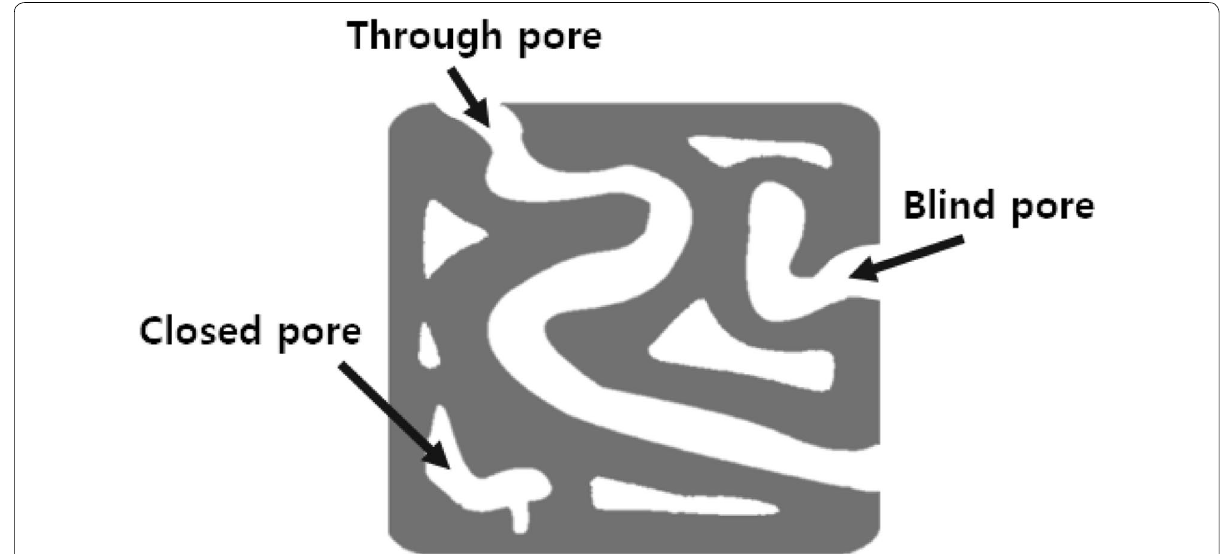
Fig. 2 The schematic illustration of three types of pore in solid porous materials based on